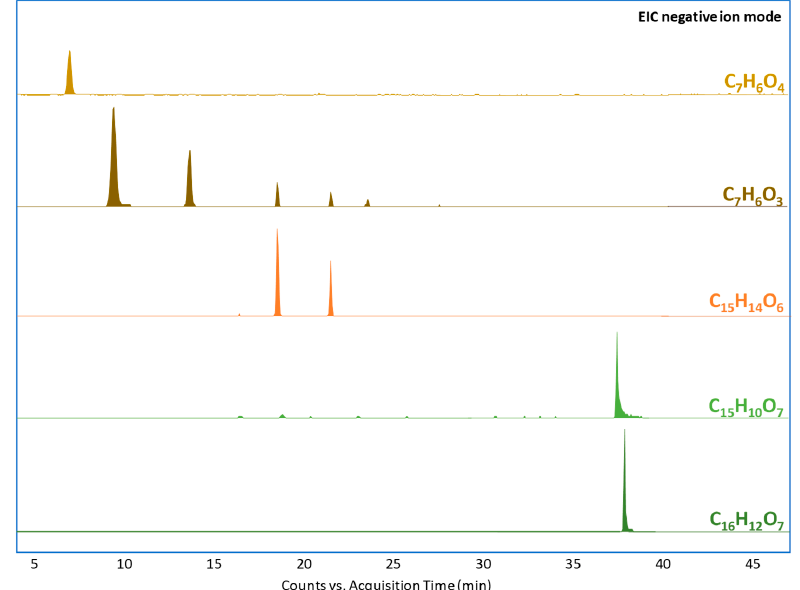
Figure 4. Extracted ion chromatograms from the extract of the nonaged yarn dyed with Acacia catechu and without mordant. The molecular formulas correspond to 3,4-dihydroxybenzoic acid (C 7 H 6 O 4 , m/z 153.0193), 4-hydroxybenzoic acid and 3-hydroxybenzoic acid (C 7 H 6 O 3 , m/z 137.0244), catechin and epicatechin (C 15 H 14 O 6 , m/z 289.0718), quercetin (C 15 H 10 O 7 , m/z 301.0354), and rhamnetin (C 16 H 12 O 7 , m/z 315.0510).